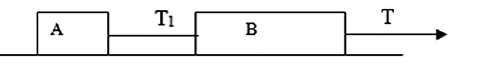
FIG. 19. Figure for Newton ’ s Laws post-test Problem 9.